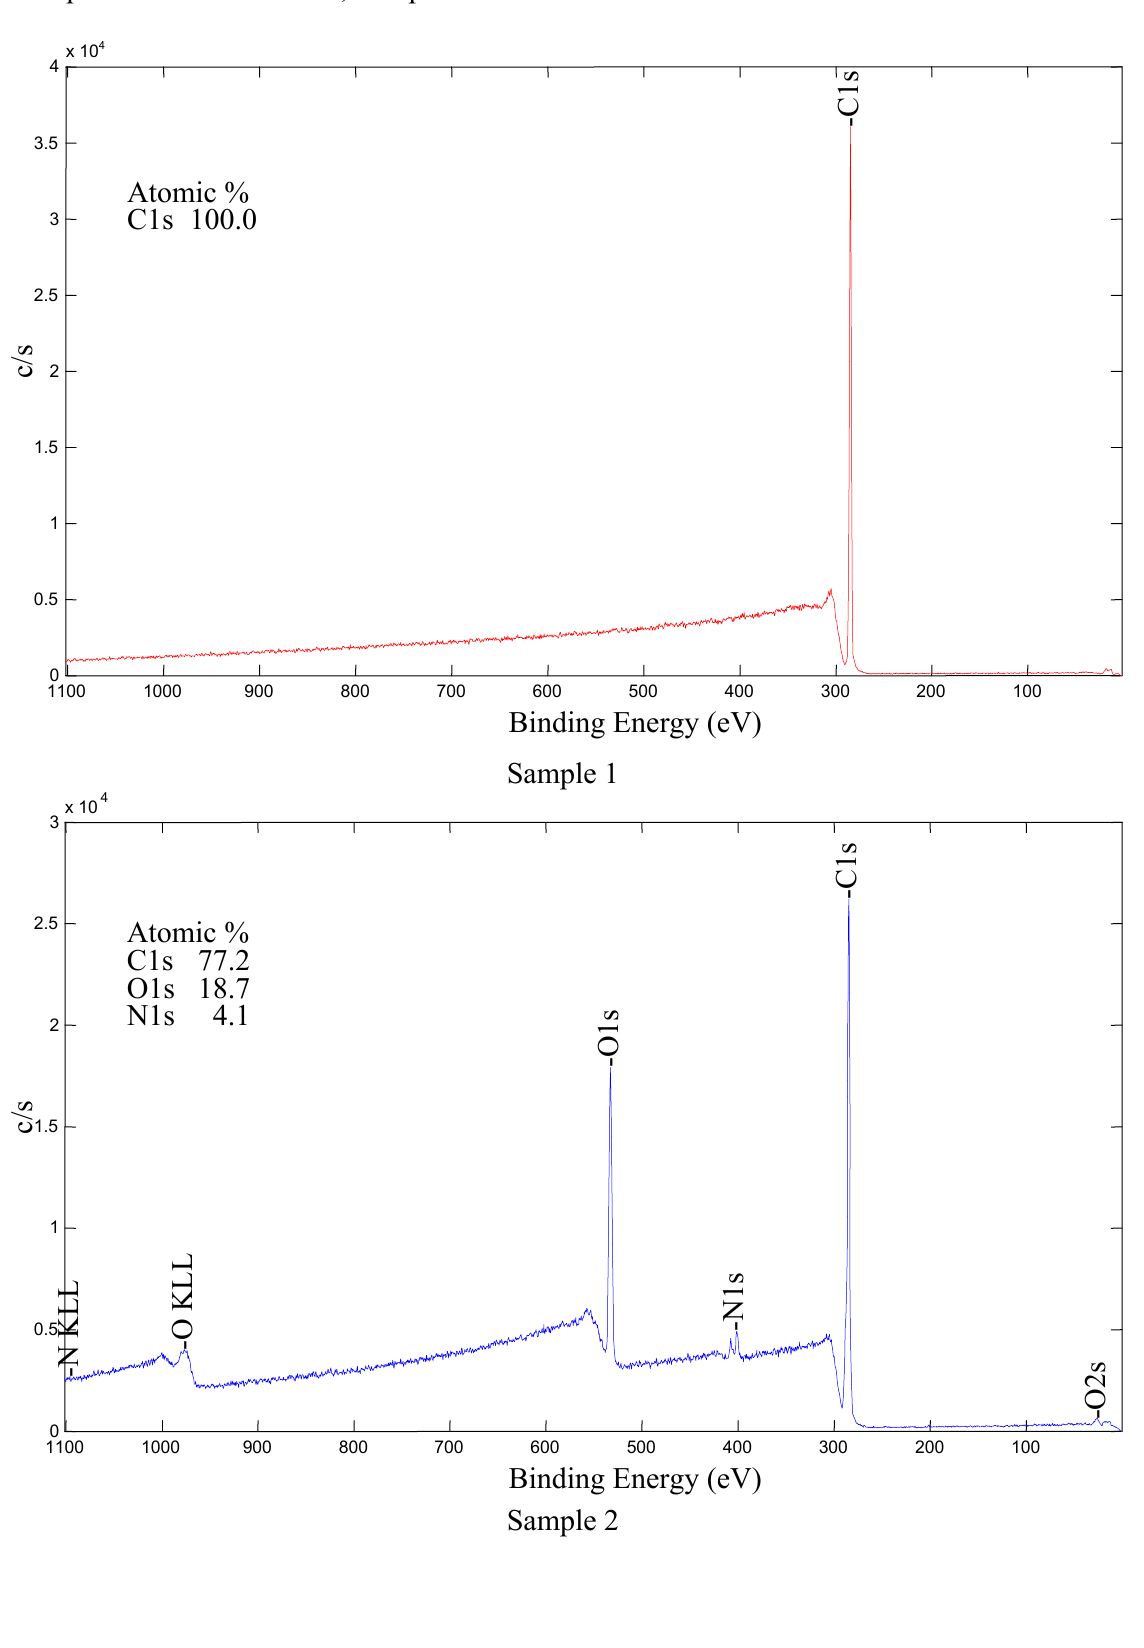
Figure 7. XPS survey-scan spectra of Samples 1–5 with atomic compositions; Sample 1 - untreated LDPE; Sample 2 - plasma-treated; Sample 3 - AA grafted; Sample 4 - triclosan coated; Sample 5 - chlorhexidine